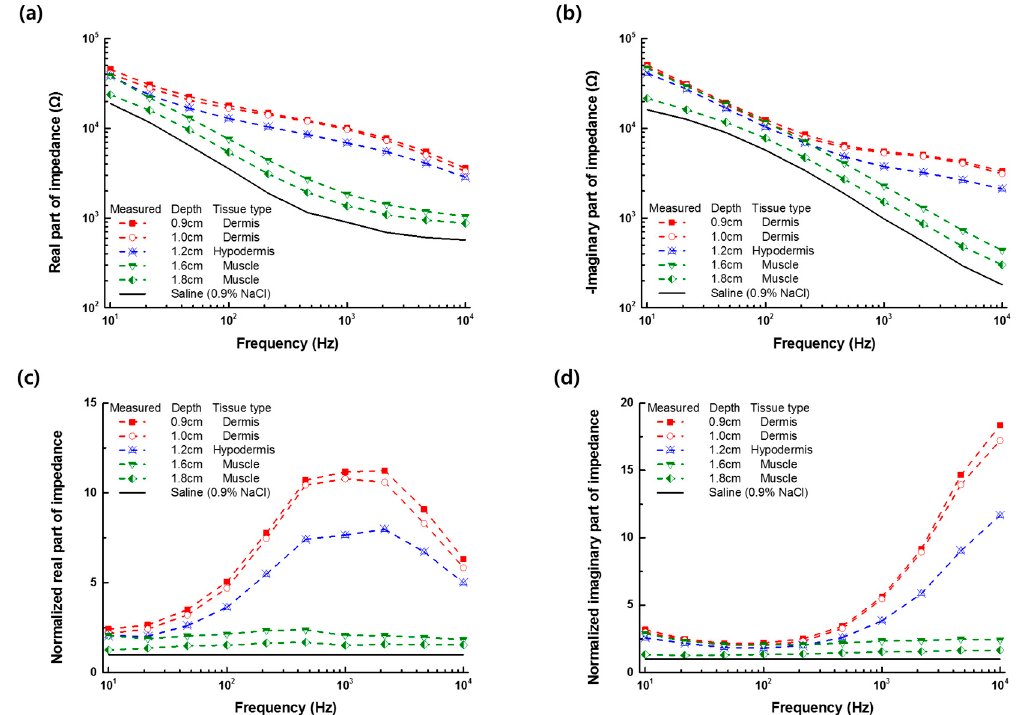
Figure 4. ( a ) Real and ( b ) imaginary part of the impedance spectra measured at different depths of the needle in the dermis, hypodermis, or muscle tissue; and normalized ( c ) real and ( d ) imaginary part of the impedance spectra to the data of the saline (0.9% NaCl) solution.